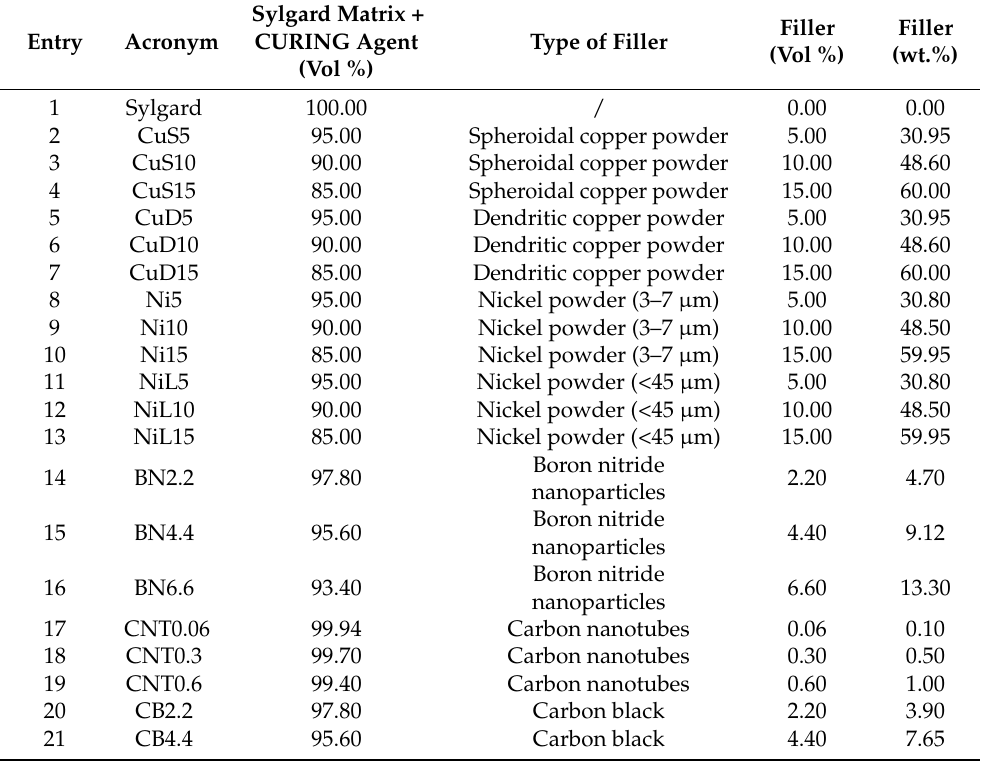
Table 1. Composition of the tested formulations, showing the different fillers and the volume percentage used for the comparison; weight percentage of the filler is